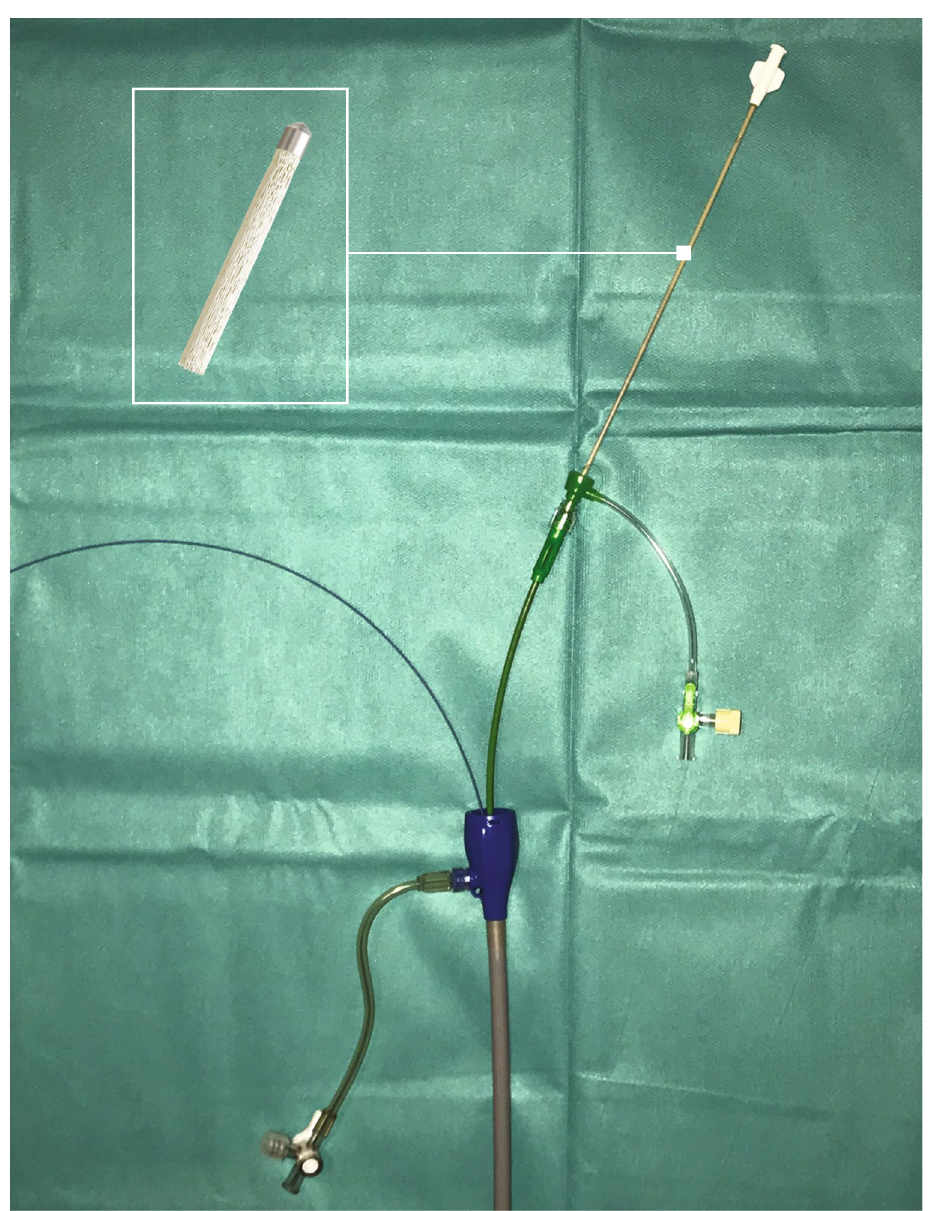
Fig. 3 Large transfemoral access sheath for aortic endograft and a parallel wire with 6‑Fr sheath for shape memory polymer device deployment into the aneurysm sac behind the endograft. Inset: illustration of the crimped form of the shape memory polymer device, which is supplied in